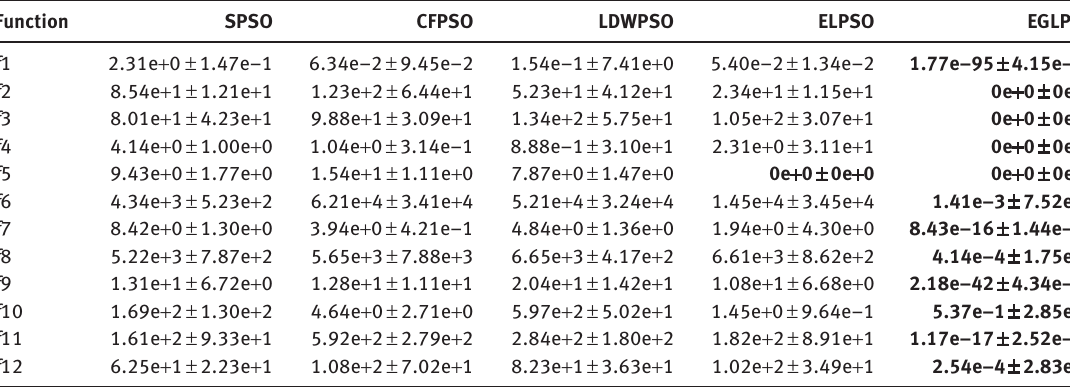
Table 3: The Optimization Results ( D = 30, mean ±